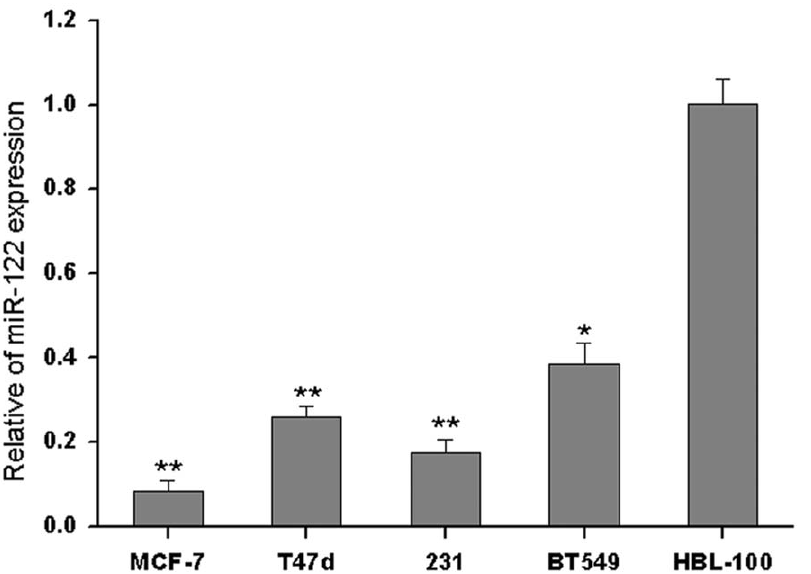
Figure 1. The expression of miR-122 is suppressed in BC cell lines. The miR-122 expression levels of MCF-7, T47d, MDA-MB-231, BT549 and HBL-100 cells were detected by qRT-PCR. The relative expression of miR-122 was normalized to the endogenous control U6. Each sample was analyzed in triplicate. (*p , 0.05, **p , 0.01).